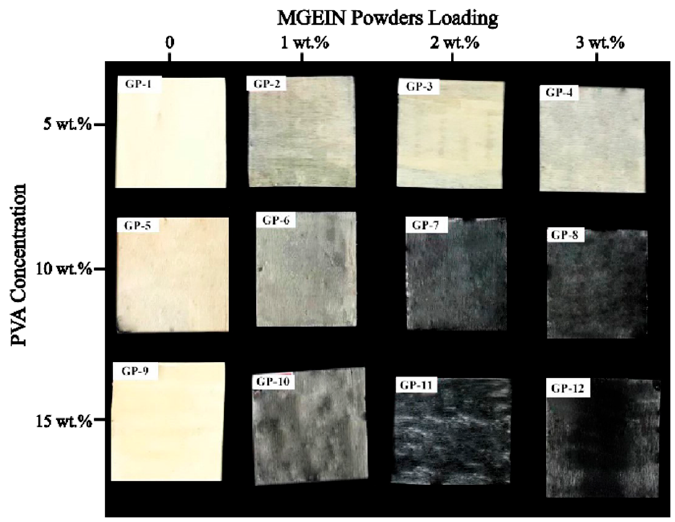
Figure 5. Colors of Gr/PVA impregnated modified veneers .